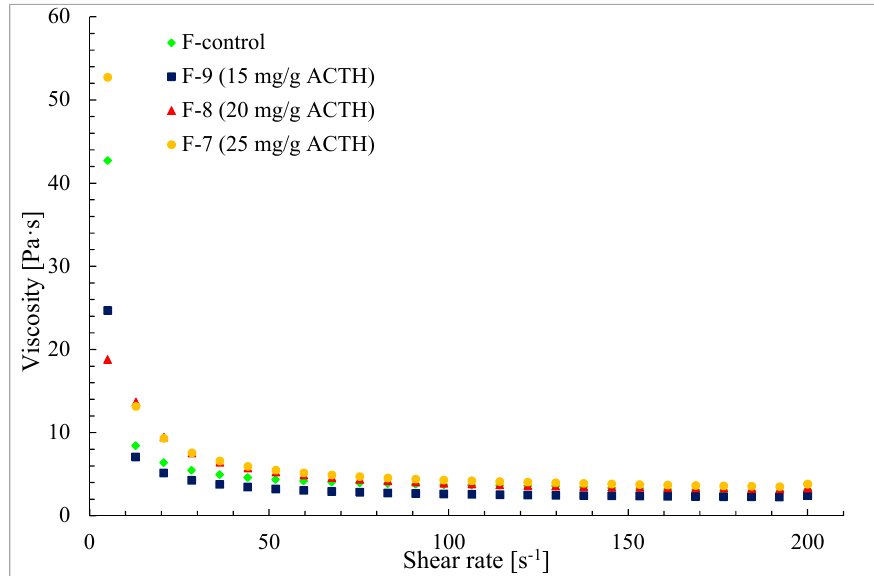
Figure 4. Viscosity curves of hydrogel F-7–F-9 and F-control (Glicerol ointment).